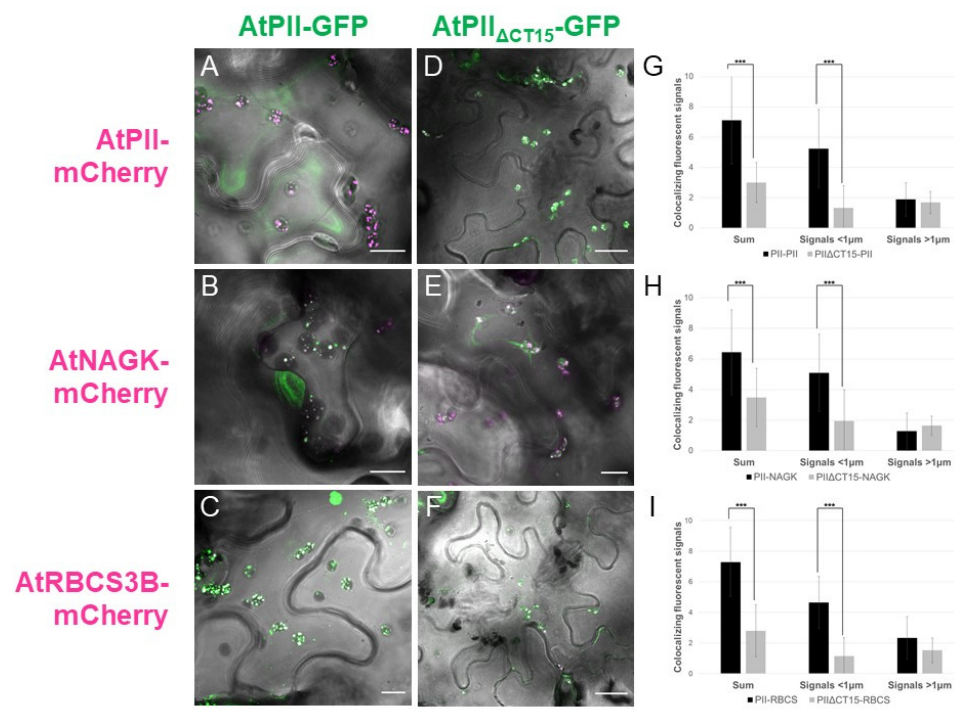
Figure 7. Truncation of the C-terminus of At PII leads to different aggregation behavior. At PII-GFP or At PII ∆ CT15-GFP were co-expressed either with At PII-mCherry (( A , D ), respectively), At NAGK- mCherry (( B , E ) , respectively) or At RBCS3B- mCherry (( C , F ), respectively), under the control of p35S in N. benthamiana . Each of these pictures shows the merge of GFP and mCherry fluorescence with the brightfield image as background. Size bars show 10 µ m except for ( D ) and ( F ) where they indicate 22 µ m. In G-I, the average total number (Sum) and the number of small and large co-localizing fluorescent signals per chloroplast for the co-expressions of At PII-GFP/ At PII ∆ CT15 -GFP + At PII- mCherry ( G ), + At NAGK-mCherry ( H ), and At RBCS3B-mCherry ( I ) are provided ( n = 25). Student’s t -test used for calculation of significance. *** p <